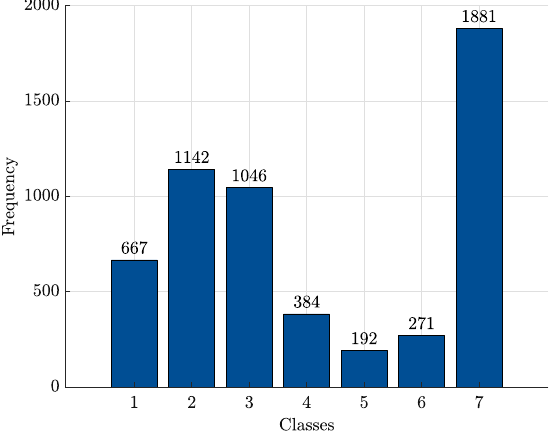
Figure 3. Classes distribution within the final 5583 proteins